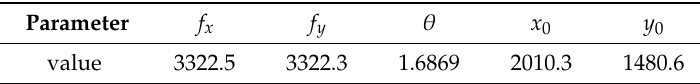
Table 1. Intrinsic parameters of iPhone 7 back